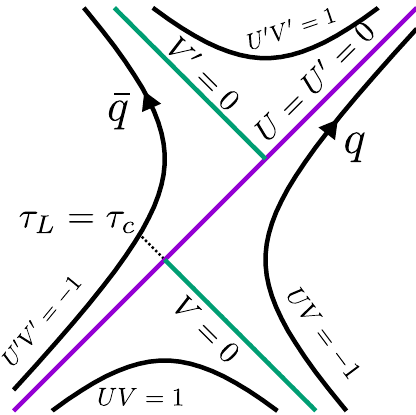
Figure 6. Spacetime structure of the perturbed string worldsheet for the decreased acceleration. An “one-way traversable wormhole” is created after τ L = τ c